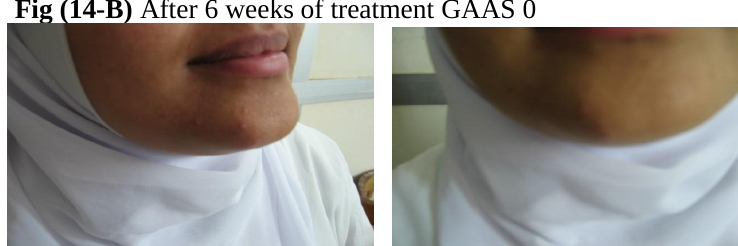
Fig (15-A) A case of acne GAAS I before the treatment